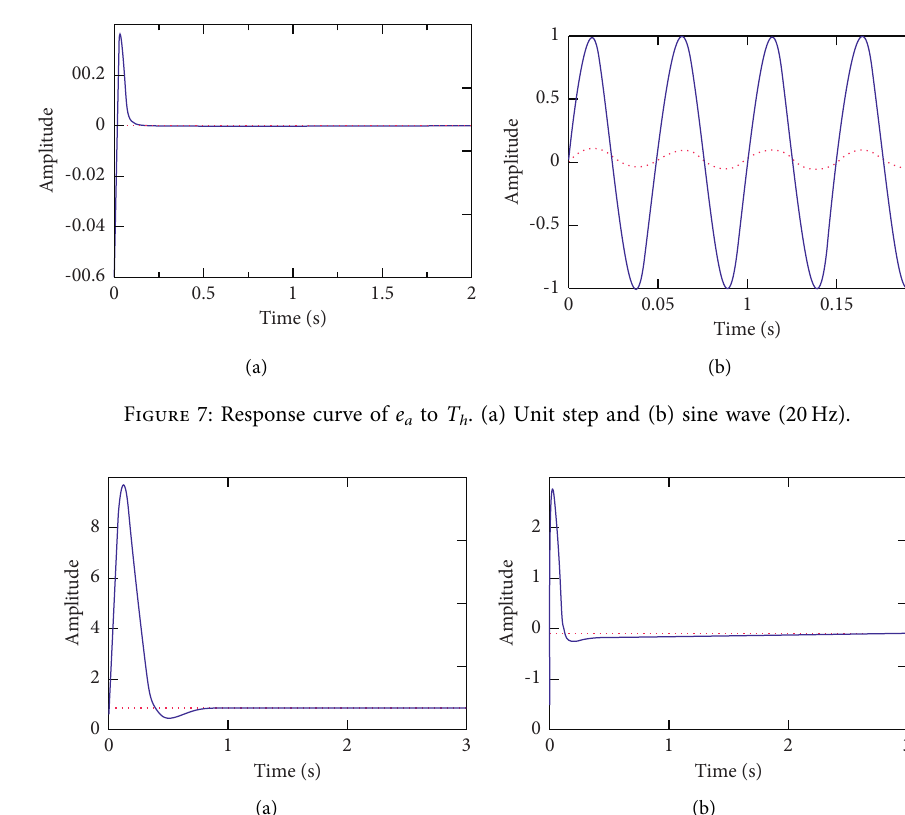
W ( s ) � 1/ ( s + 0 . 5 ) and (b) W s 1 f to T h . (a)